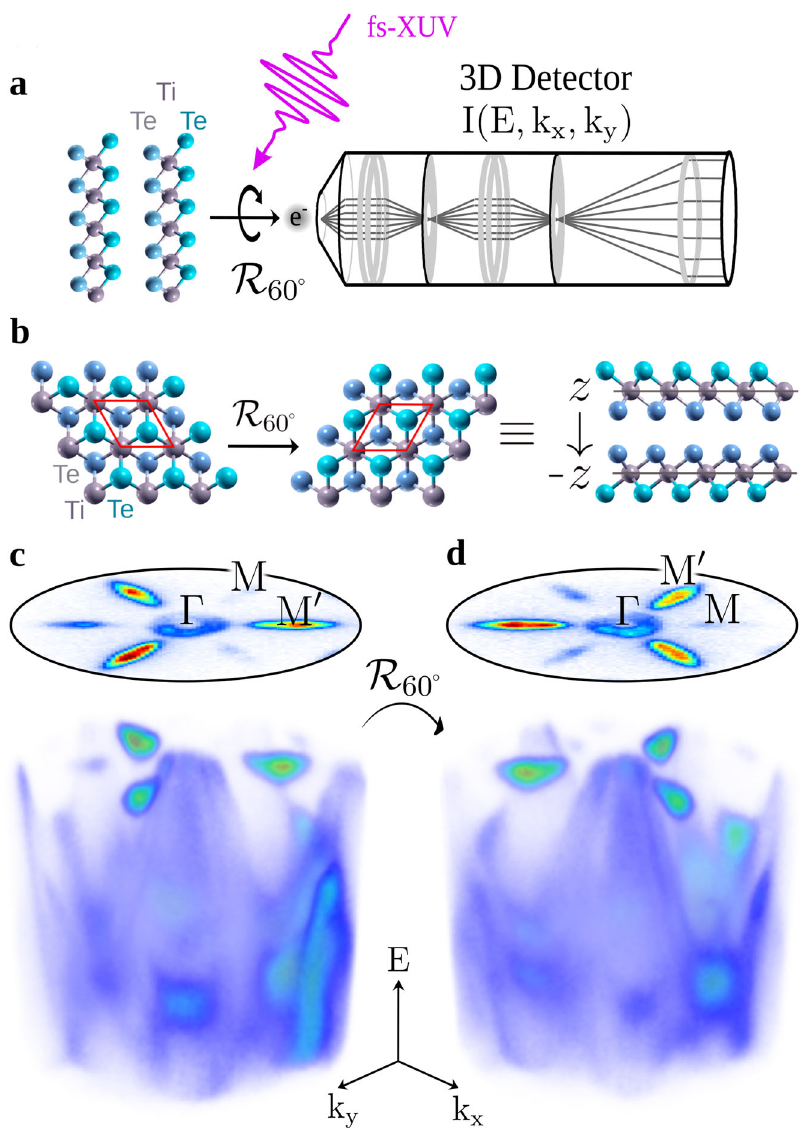
Fig. 1 Scheme of the multidimensional photoemission spectroscopy experiments. a A p -polarized fs-XUV (21.7 eV) pulse is focused onto a freshly cleaved bulk 1T-TiTe 2 crystal at an angle of incidence of 65° with respect to the surface normal, emitting photoelectrons which are detected by a time-of- fl ight momentum microscope (METIS1000, SPECS GmbH). The crystal is orientated in the laboratory frame such that the light polarization axis is along the Γ − M / M ' direction. b Schematic of the equivalence between a crystal rotation by 60° ( R 60 (cid:2) ) in the laboratory frame and a mirror operation ( z → − z ), in 1T-TiTe 2 . Indeed, the 1T- polytype is strictly equivalent to a mirror operation across the z plane of each layer ( z → − z ). c Three-dimensional photoemission intensity I ( E , k x , k y ), and associated constant energy contour (CEC) at the Fermi energy ( E − E F = 0 eV). d Same as ( c ), but following a crystal rotation by 60° in the laboratory the dichroism extracted after rotating the crystal orientation by valleys, and weaker dichroism (up to ±35%) with the same 60 ∘ . The measured A 60 (cid:2) threefold symmetry and sign texture for the Te-5 p hole pockets dichroic signal is almost perfectly LDAD around Γ . The dichroic signal is not perfectly up/down ( k y > 0/ k y < antisymmetric with respect to A 0 (cid:2) , again indicating its intrinsic LDAD 0) symmetric, suggesting small experimental imperfection in the origin since an extrinsic (experimental geometry) origin would crystal orientation, XUV beam alignment, or photoelectron have led to a dichroic signal invariant upon an operation. imaging, since the up/down symmetry, should not be broken within this experimental con fi guration (i.e. p -polarization along Γ − M/M ′ ). Moreover, since we are dealing with normalized signals (see Eq. (1)), we only show the dichroism for momentum regions where the right-left ( k x > 0/ k x < 0) symmetrized signal is > 0.1 I max , where I max is the maximum photoemission intensity for this CEC. This thresholding procedure ensures that we do not over-interpret the potentially strong dichroism coming from momentum regions of vanishing photoemission intensity. Figure 2e shows A 60 (cid:2) , i.e. LDAD